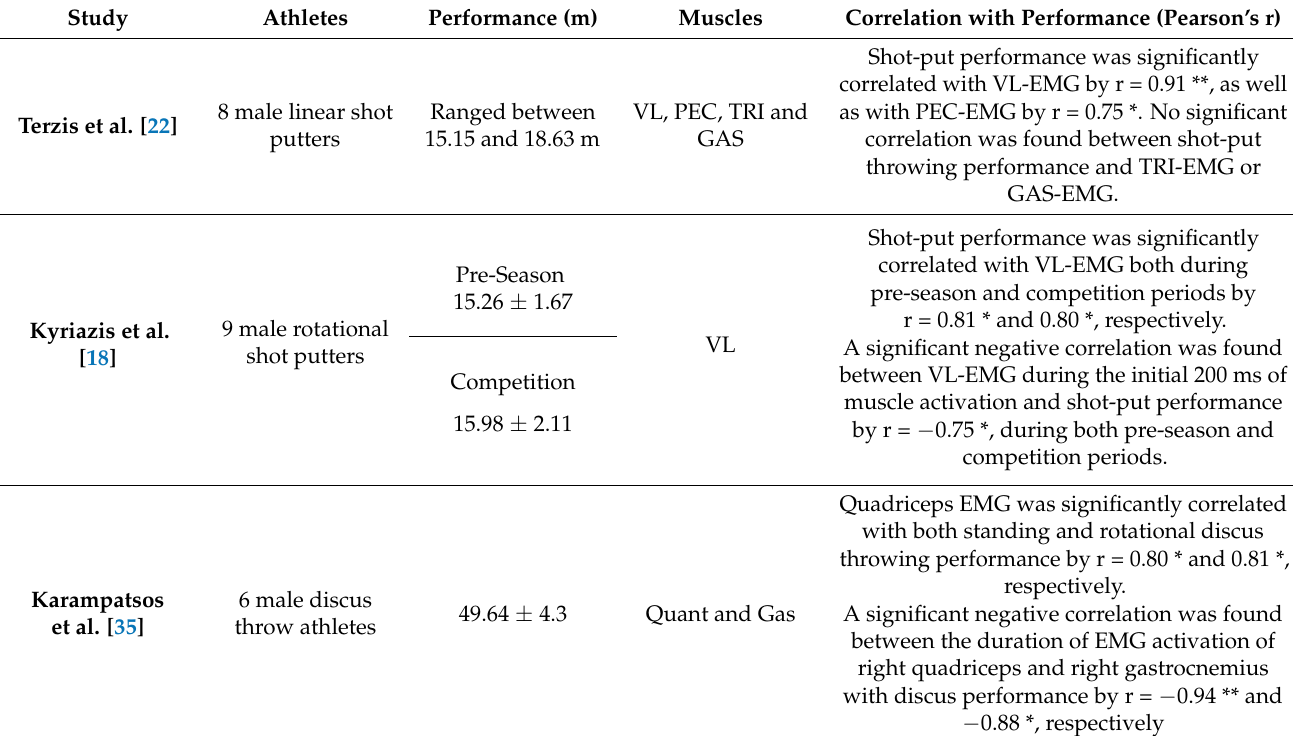
Table 2. Correlations between muscle electromyographic activation and competitive track and field throwing performance in shot-put and discus